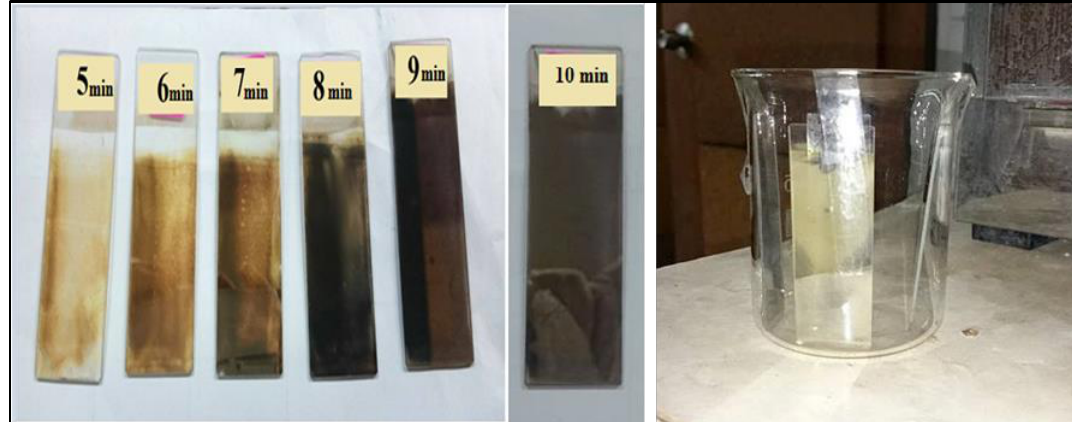
Figure 2: Ag NPs deposited on glass microscope slides by putting the slide in the hot rotation Ag NP solution at different reduction